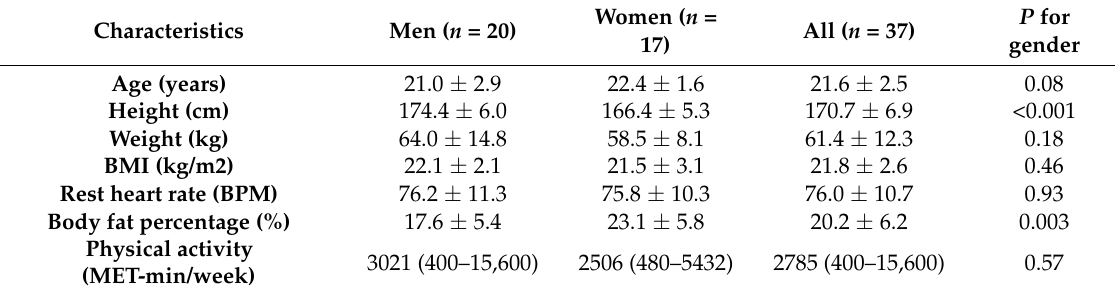
Table 1. Participants’